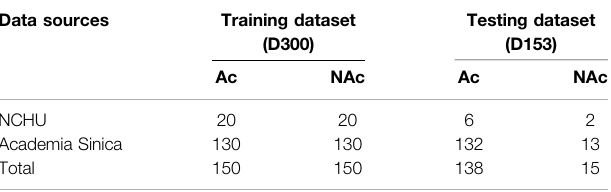
TABLE 2 | Data distribution of the training dataset and independent-testing